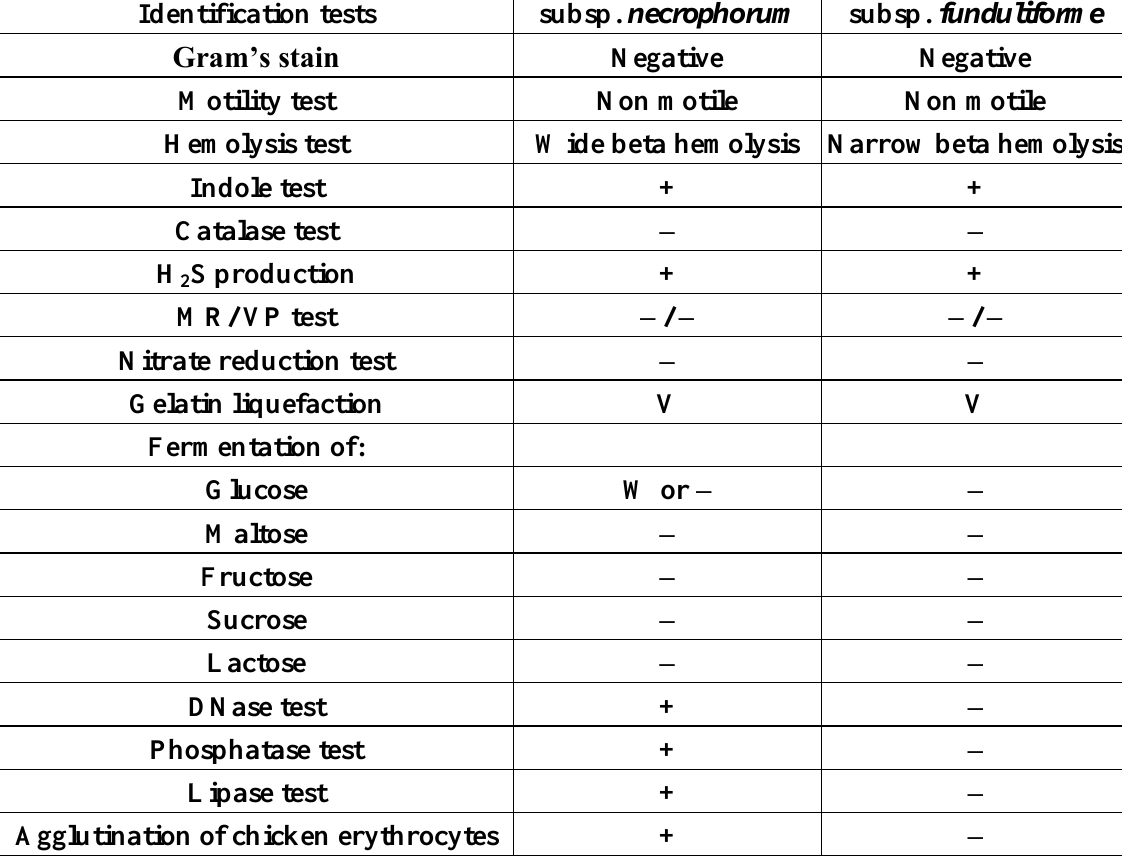
Table 1: Identification of Fusobaterium necrophorum